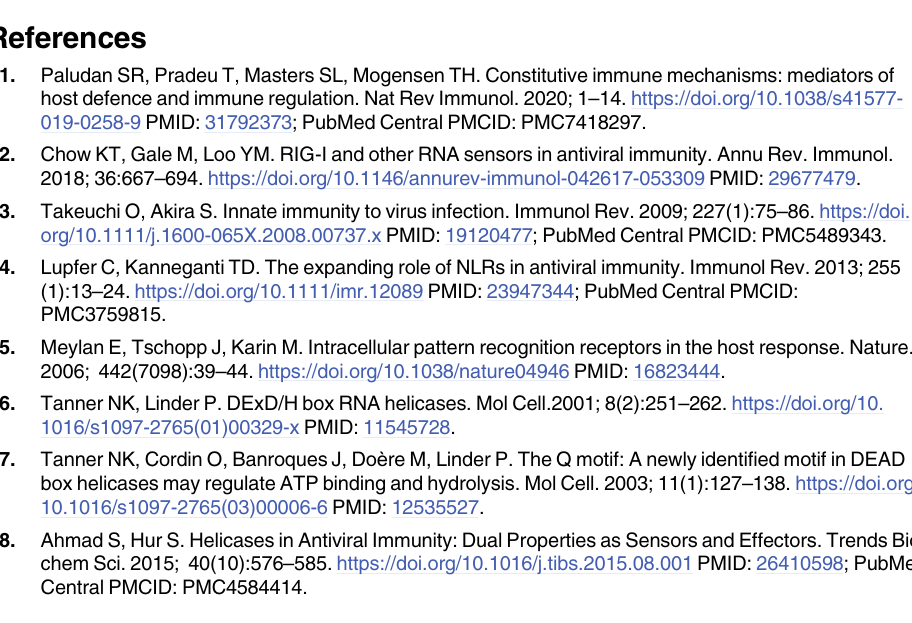
S2 Table. Primers used for gene